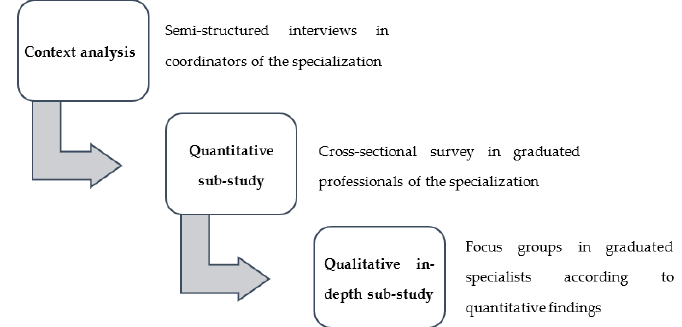
Figure 1. Methodological flow chart for the study design.